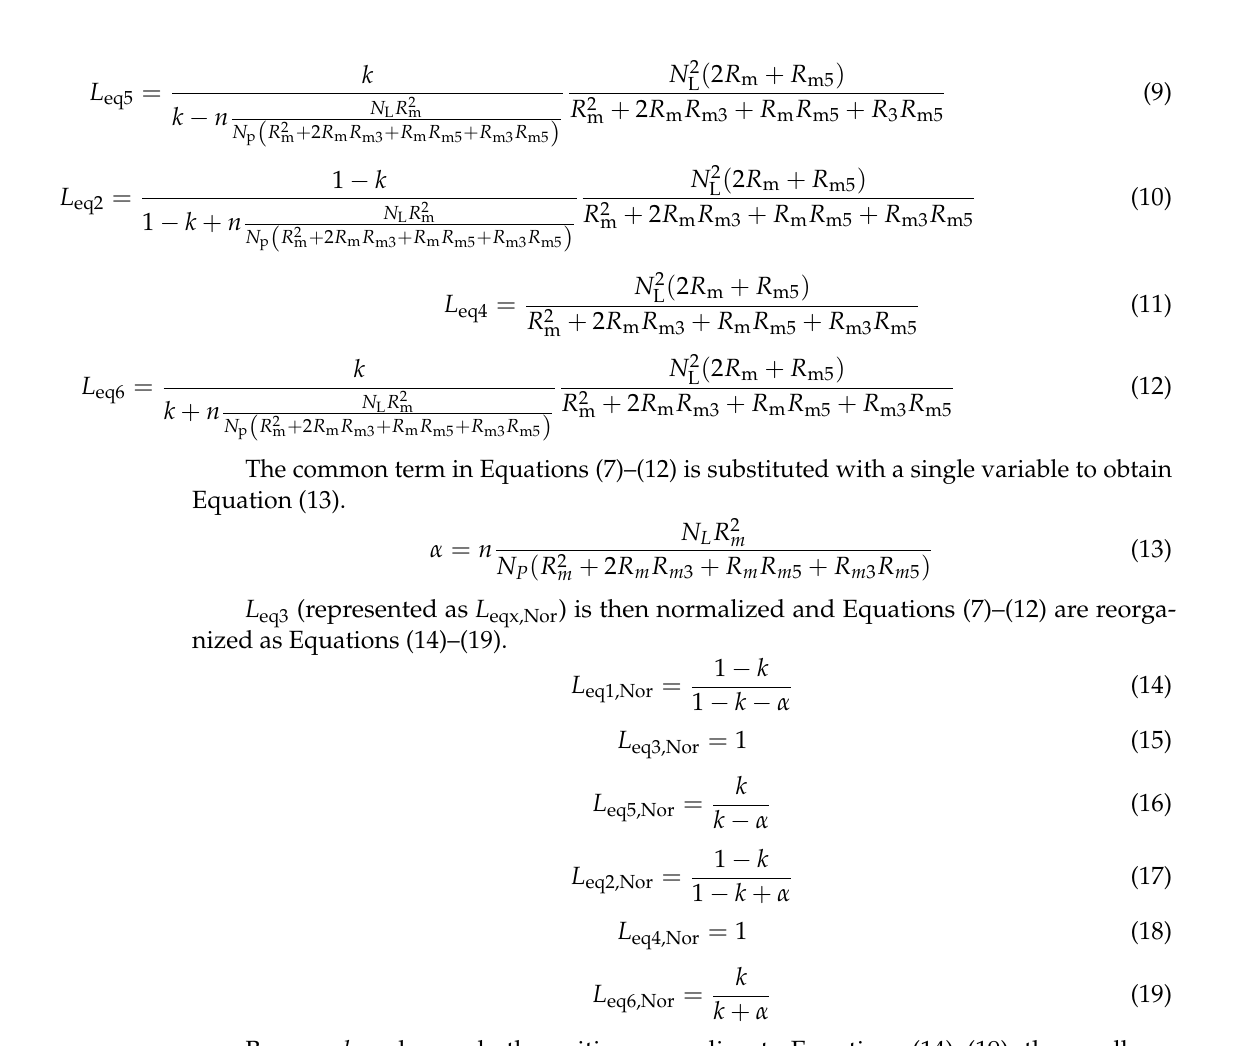
Because k and α are both positive, according to Equations (14)–(19), the smaller α is, the closer the inductance values from after integration and before integration are in each interval. When α = 0, the inductance in each interval is identical before and after integration. This result is also verified with the sensitivity curves of L eq2,Nor in relation to k and α (Figure 8).